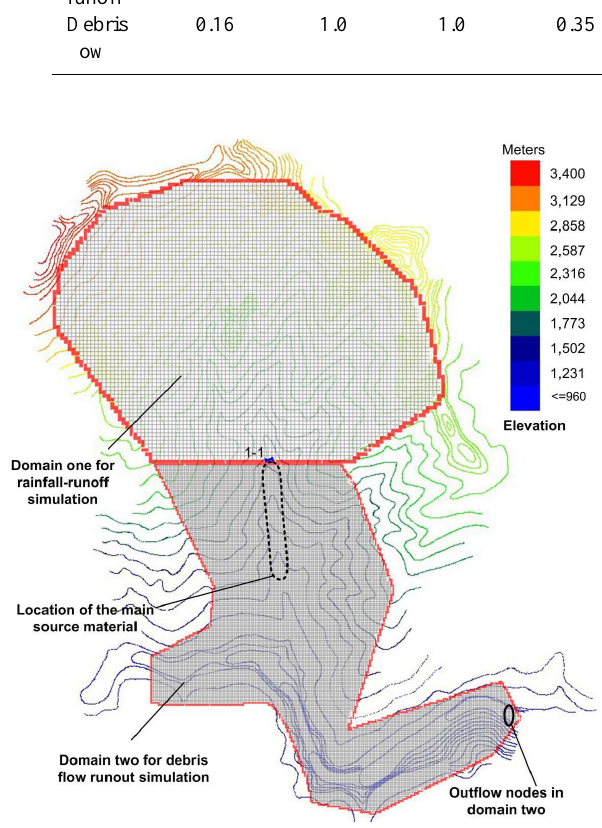
Figure 15. Grid system for rainfall runoff simulation and debris flow runout simulation.